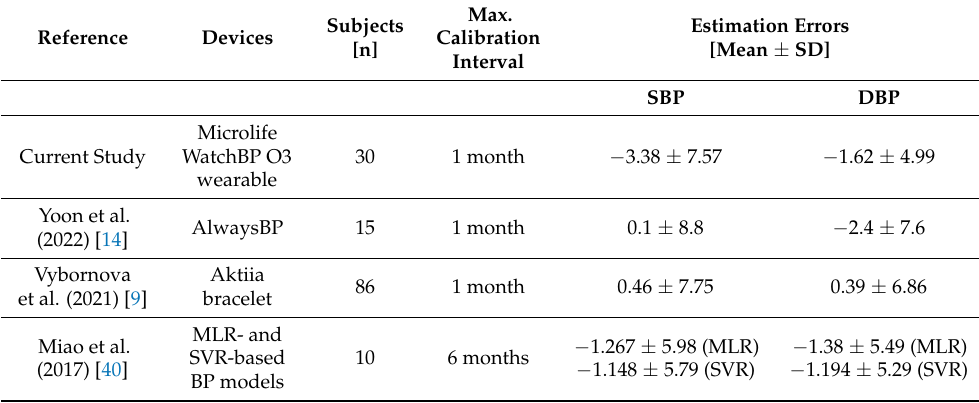
Estimation error: absolute BP difference between the test and reference devices. MLR: multivariate linear regression. SVR: support vector